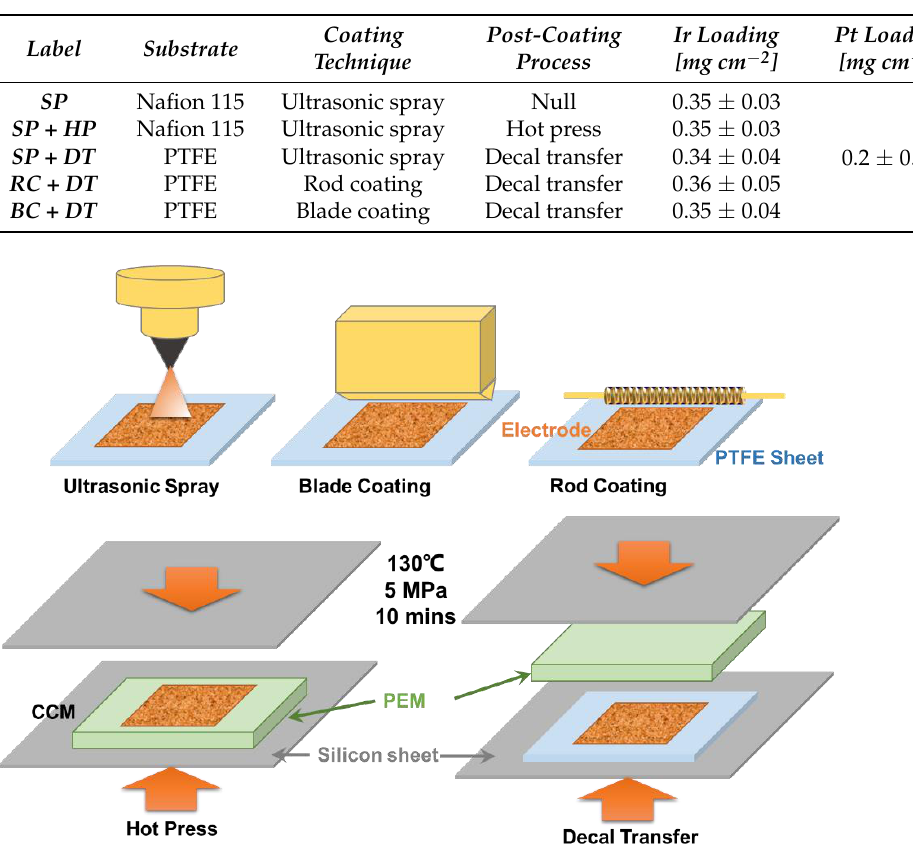
Figure 2. Schematic of the coating technique and electrode fabrication